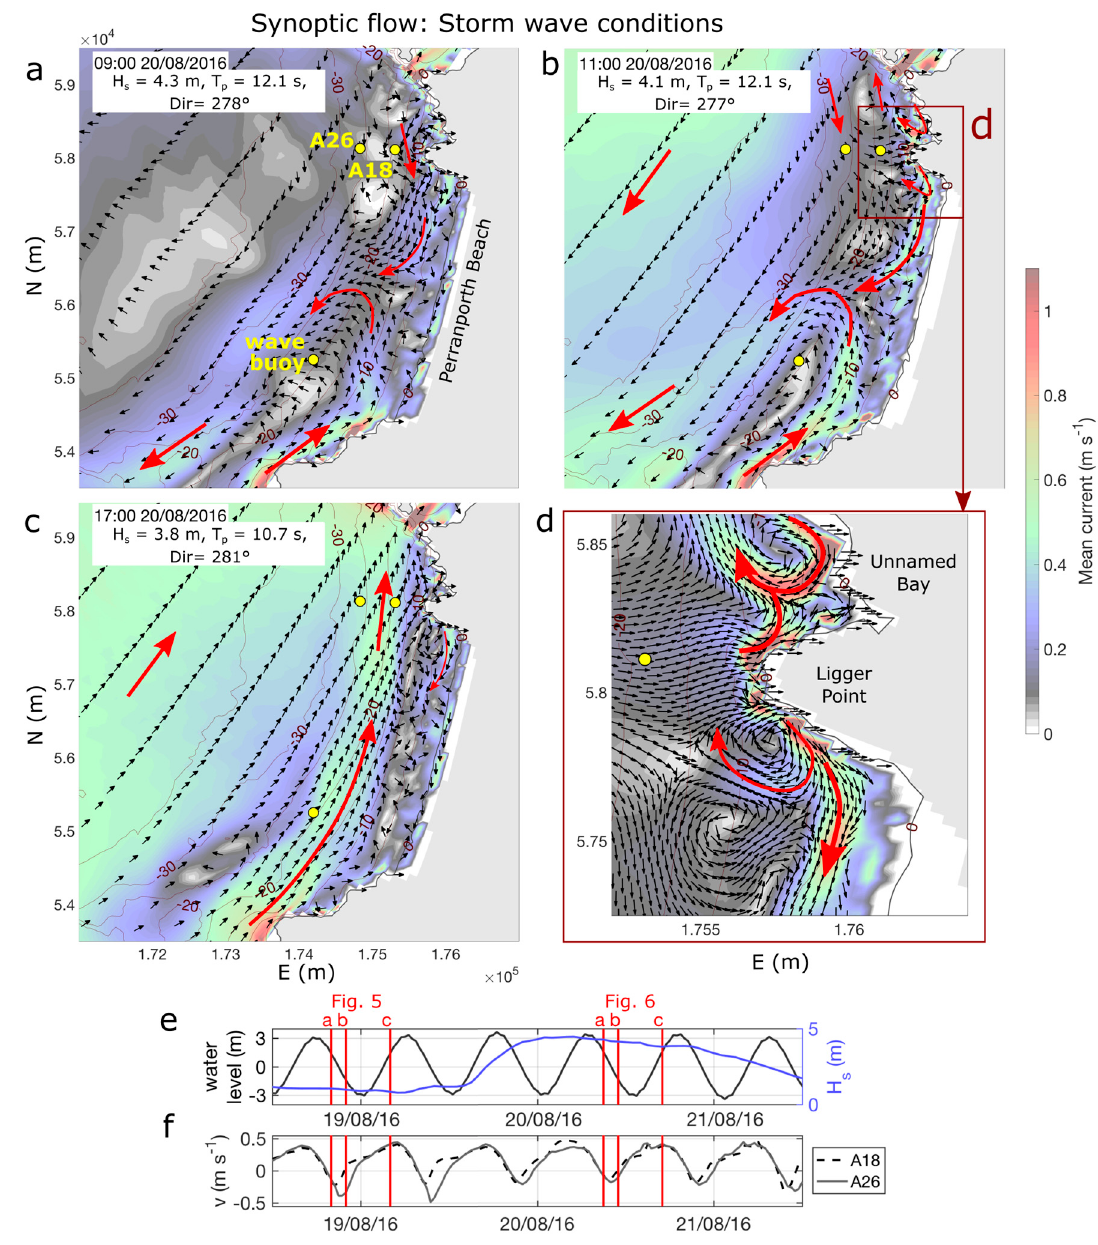
Figure 6. Synoptic snapshots (30-min averages) of simulated flow during storm conditions. ADCP and wave buoy locations are indicated with yellow dots in ( a – d ). ( d ) is a magnified inset of ( b ), with a higher resolution of current vectors indicated. The black arrows in ( a – d ) indicate direction, not magnitude; the red arrows are interpretations of primary currents. A timeseries of water level and wave height ( e ) and alongshore velocity ( f ) are provided with snapshot times for Figures 6a–c and 5a–c, indicated by red lines.